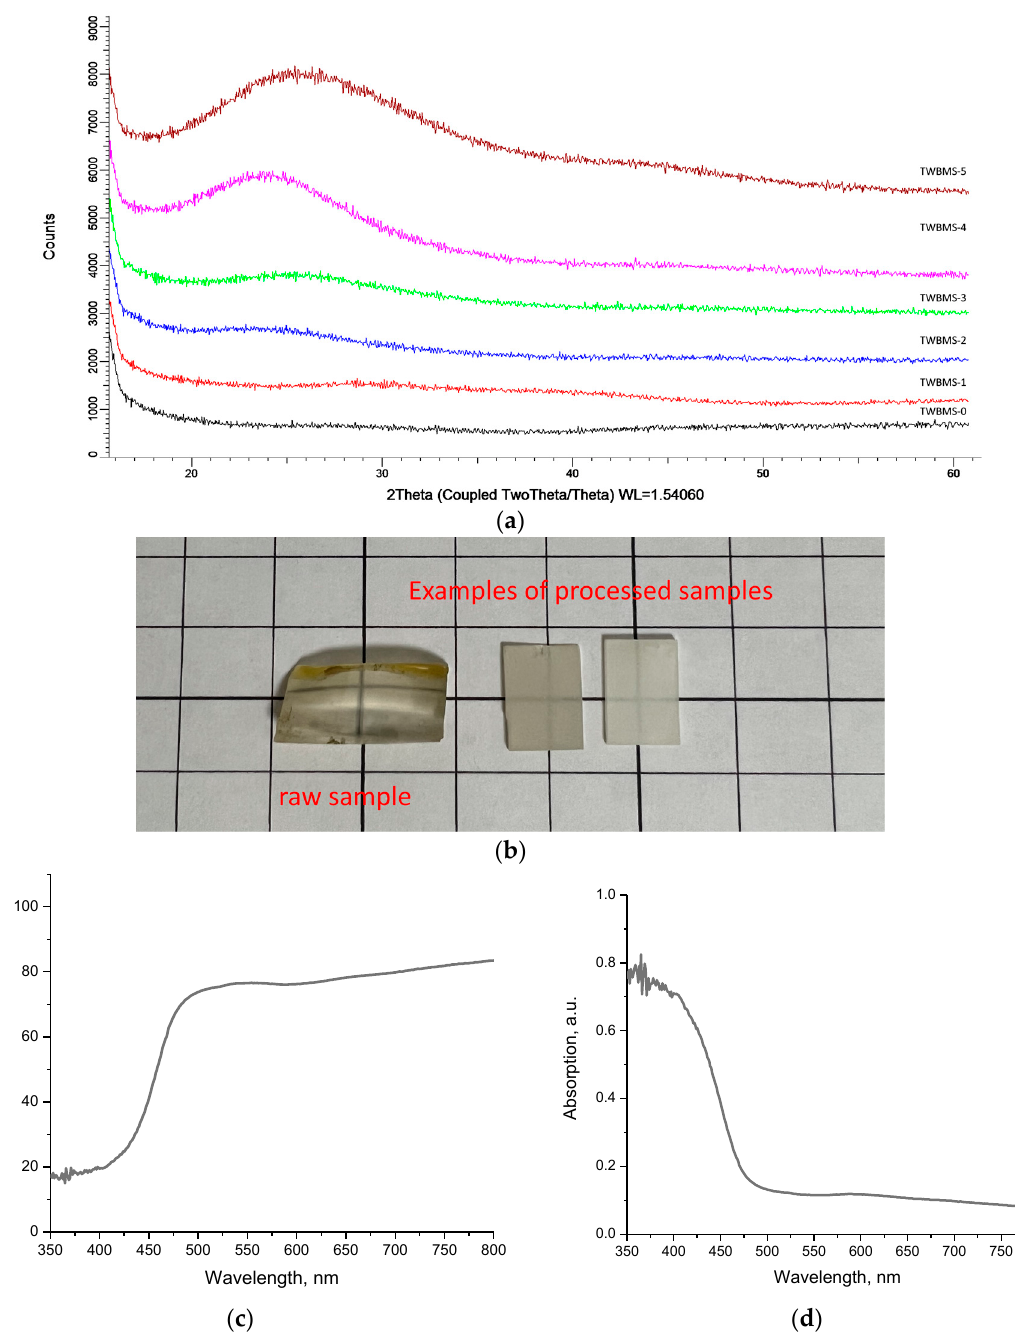
Figure 1. ( a ) Results of X-ray phase analysis; ( b ) examples of images of obtained glasses before and after processing; ( c ) results of optical measurements of transmission spectra; ( d ) results of optical measurements of absorption spectra.